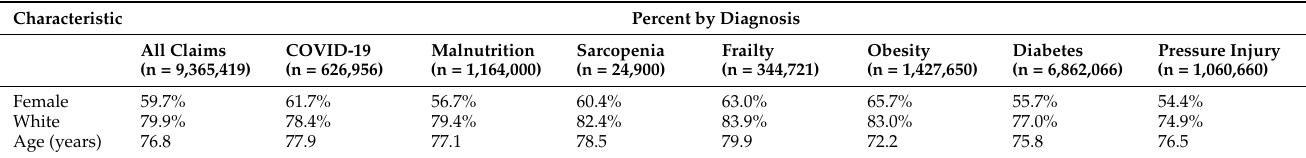
Table 1. Demographic characteristics for the skilled nursing facility US Medicare claim set of specific diagnoses * (n = 9,365,419).